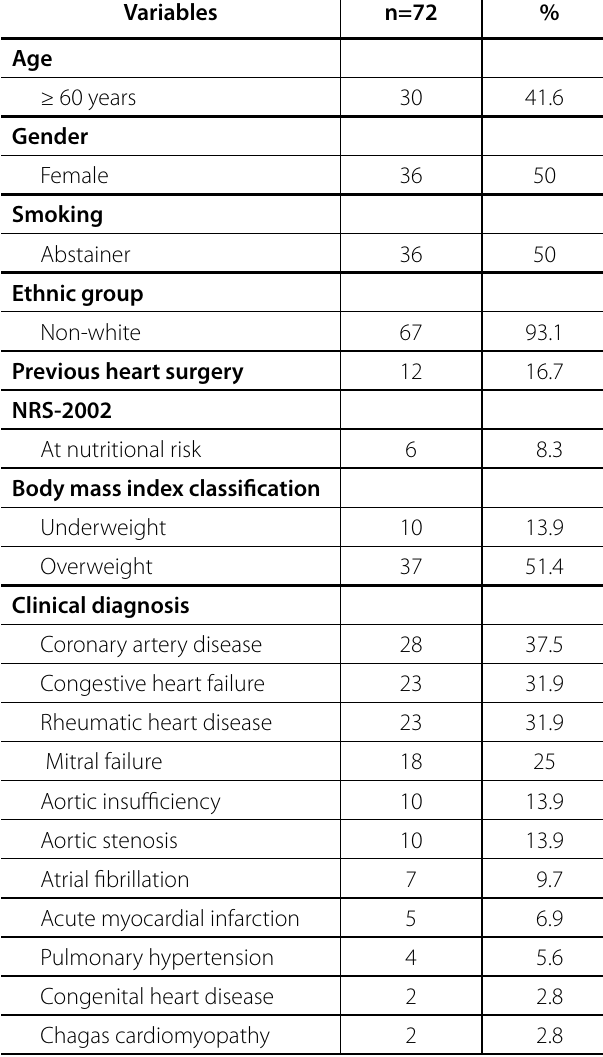
Table 1. Characterization of patients subjected to major elective cardiac